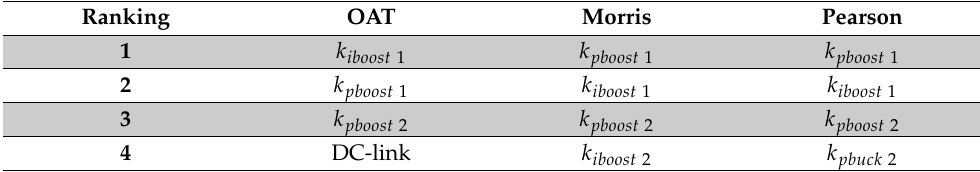
Figure 13. Heatmap for ranking critical parameter for resonance. Table 7. Influential parameters identified using the different sensitivity method (oscillation stability).